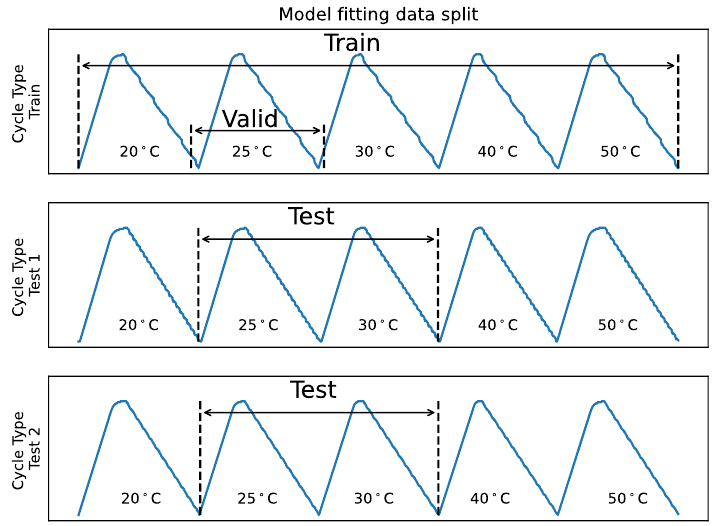
Figure 8. Three profiles’ cross-validated data, split for training, validation, and testing in a simplistic SoC cycle representation under different temperatures.